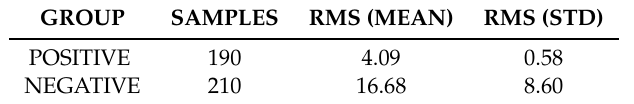
Table 3. Summary statistical results of the previous table. The RMS sEMG unit of measurement is µ